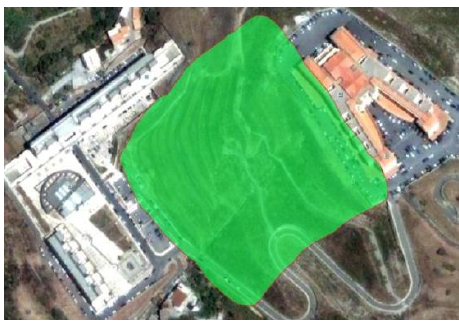
Figure 2. Extension of the study area